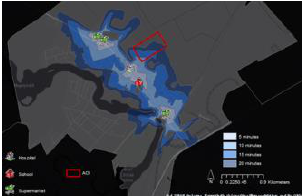
Figure 4. Accessibility of the study area to the existing public services